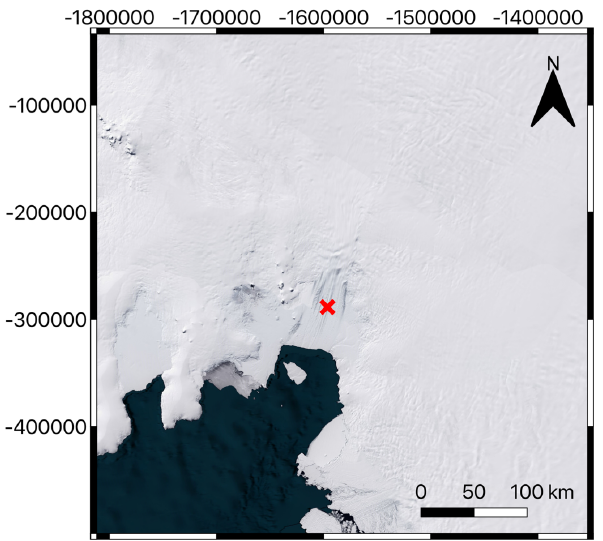
Figure 16. Comparison of (a) two 6d (20190110–20190116 and 20190122–20190128) ITS_LIVE Sentinel-1 image-pair velocity (b) with the MEaSUREs Annual Antarctic Ice Velocity Maps av- eraged for the period of July 2018 to June 2019 over the Pine Is- land Glacier in the Antarctic. Background: © Microsoft Bing Maps